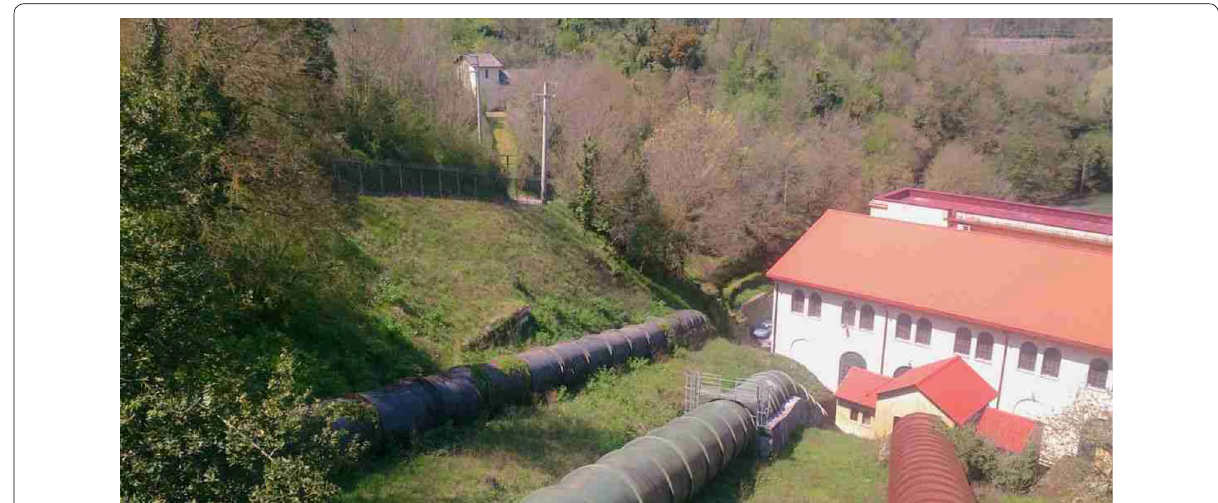
Fig. 18 Hydroelectric plant in Castel Madama IT (from www.atbrc .com)